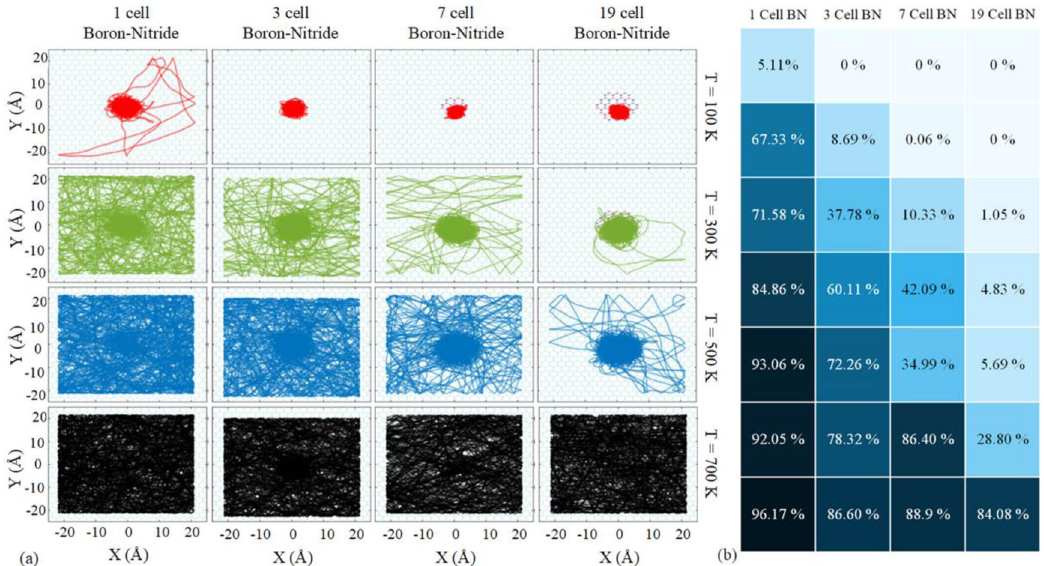
Figure 4. ( a ) Trajectory of C 60 on the graphene substrate with a boron-nitride impurity at the center (to avoid the complexity of the figure, the trajectories at the temperatures of 100, 300, 500, and 700 K are only presented). ( b ) The portion of the whole simulation time in which C 60 was located outside the impure region. Here, the graphene substrate has boron-nitride impurity in the center, as depicted in Fig. 3a.